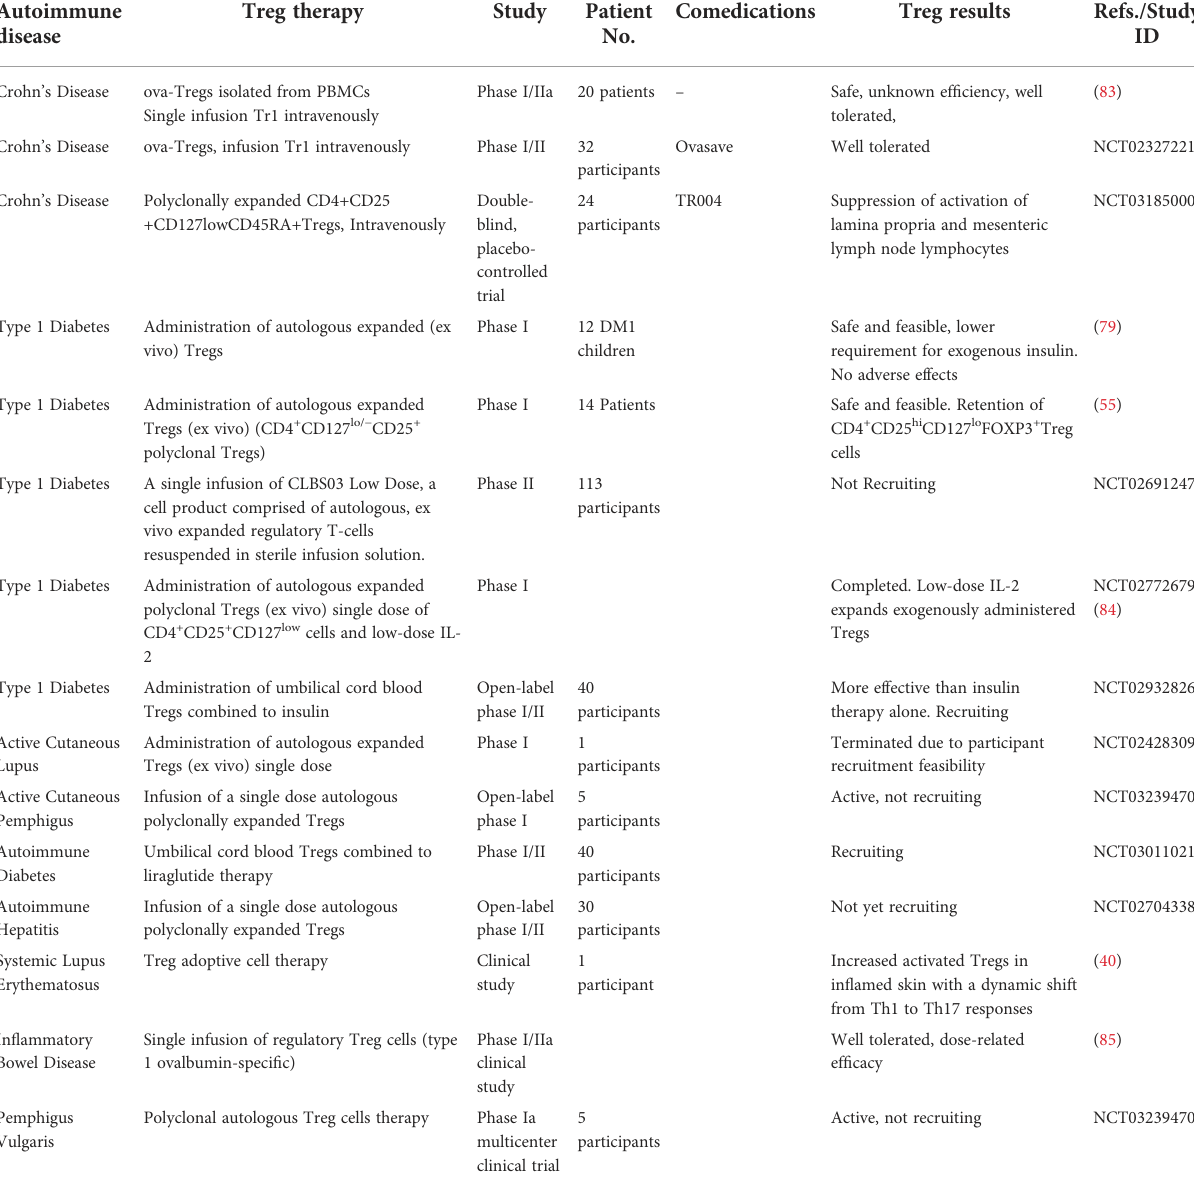
TABLE 1 Recent clinical studies on Treg cell therapy in autoimmune disease. Autoimmune